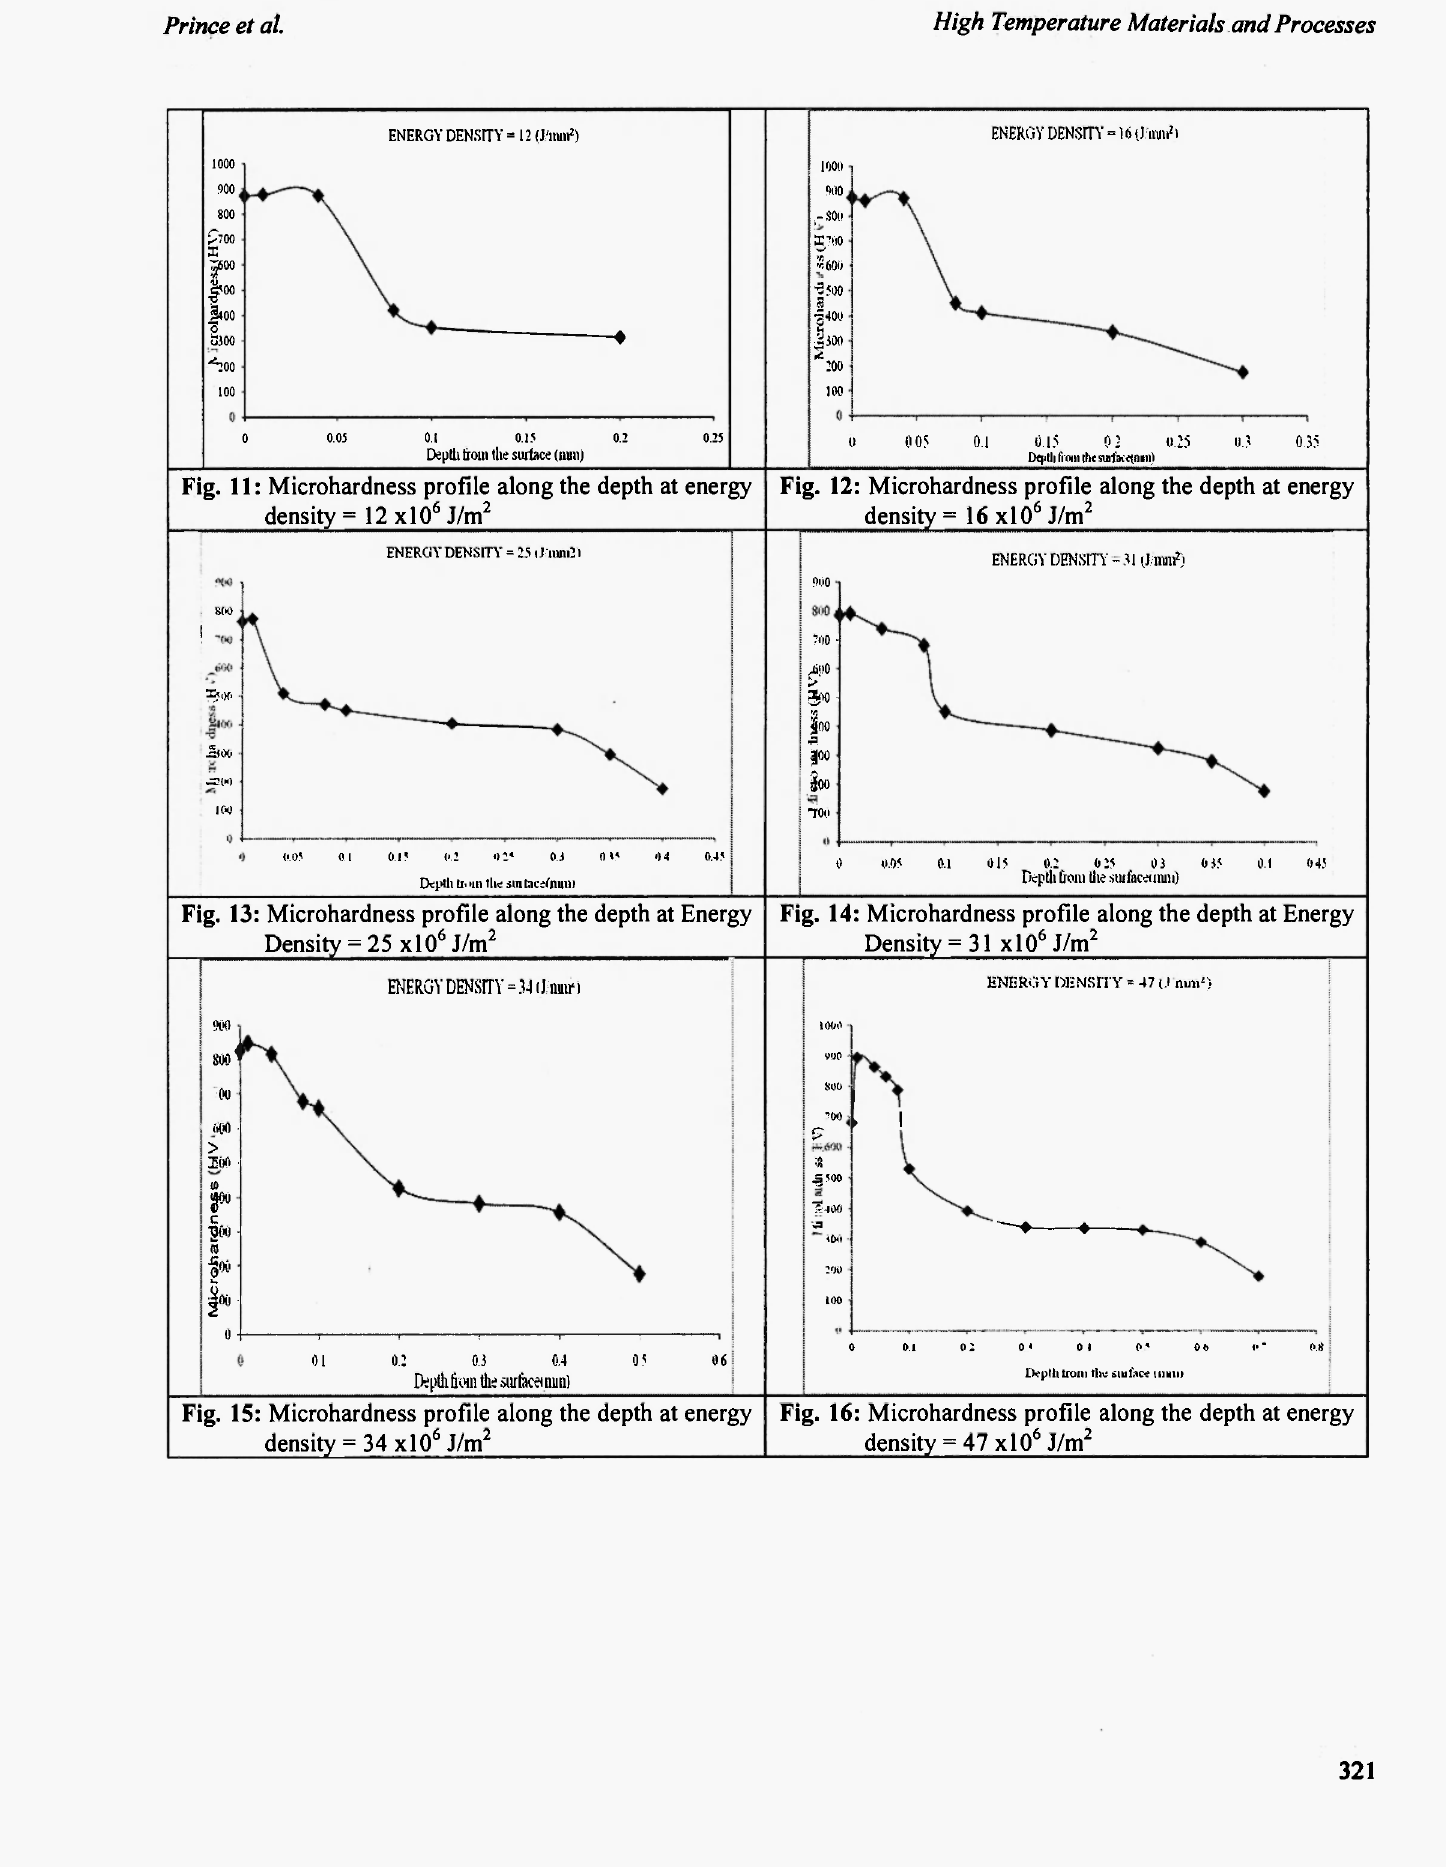
Fig. 15: Microhardness profile along the depth at energy Fig. 16: Microhardness profile along the depth at